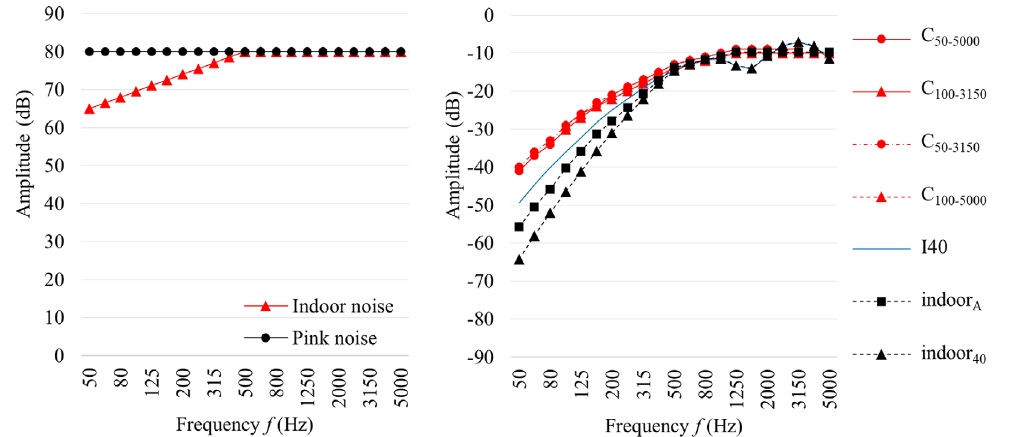
Figure 2. Left: spectrum of indoor noise used as stimulus for Zwicker ’ s Loudness based assessments. Right: adaptation spectral terms of different